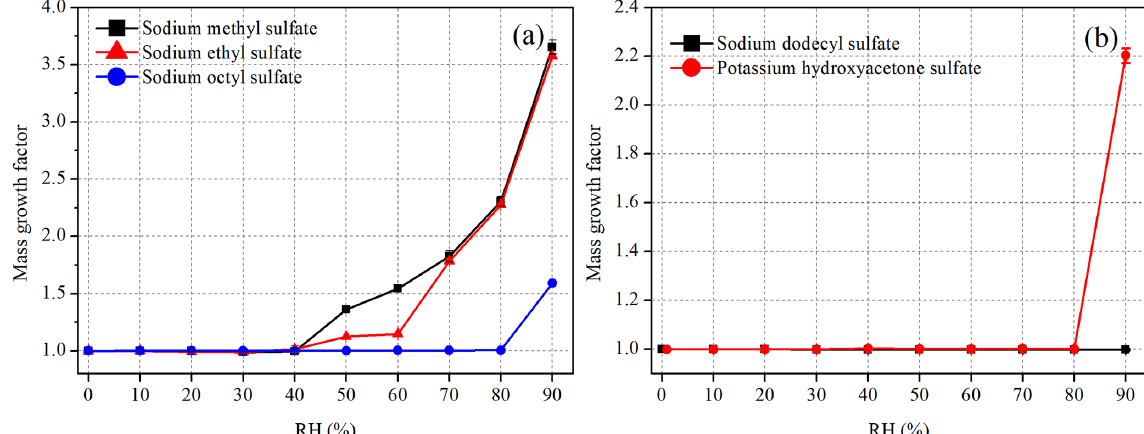
Figure 4. Mass growth factors of (a) methyl-, ethyl- and octyl-OS and (b) dodecyl-OS and potassium hydroxyacetone sulfate as a function of RH at 25 ◦ C. Please note that error bars are included, but they are too small to be clearly visible.